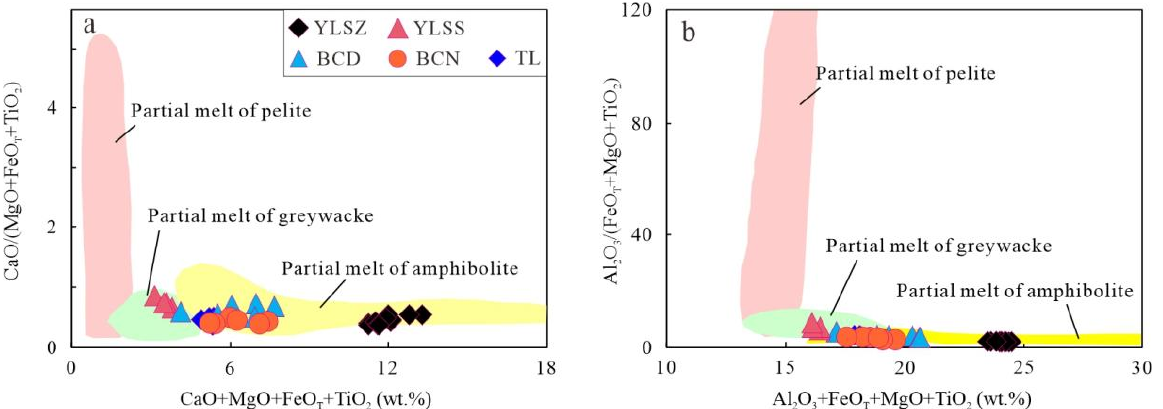
Figure 9. (CaO + MgO + FeO T + TiO 2 ) versus CaO/(MgO + FeO T + TiO 2 ) ( a ) and (Al 2 O 3 + MgO + FeO T + TiO 2 ) versus Al 2 O 3 /(MgO + FeO T + TiO 2 ) ( b ) diagrams [96] for the Yilashan and Amdo granitoids in the Nagqu area. Symbols as in Figure 6. Fields are from [97–100].